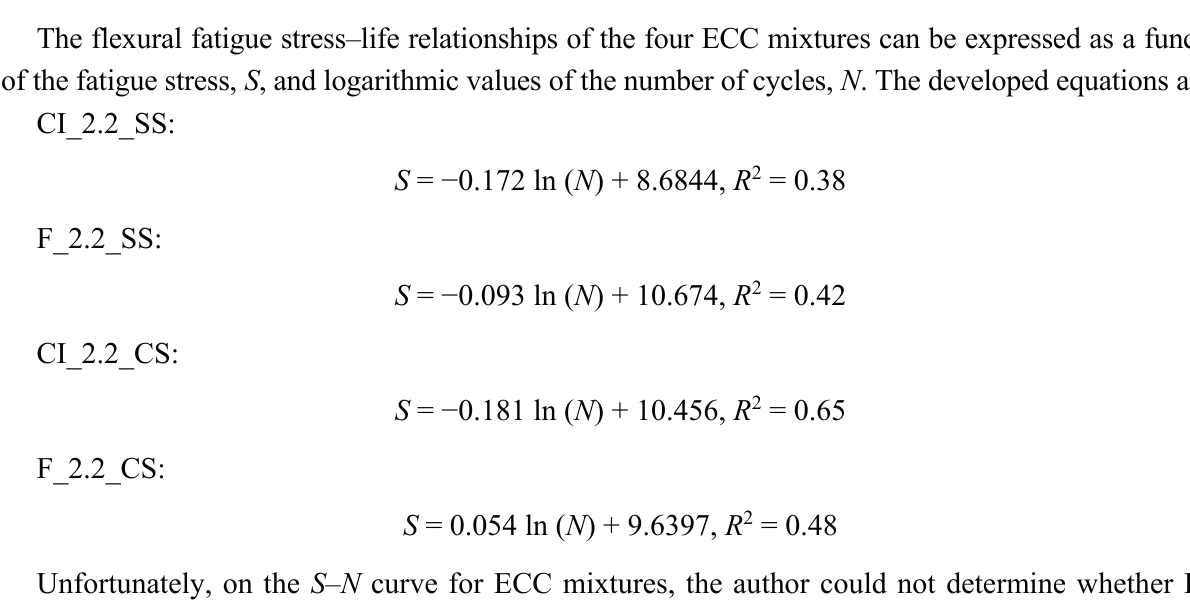
Figure 16. Fatigue stress–life